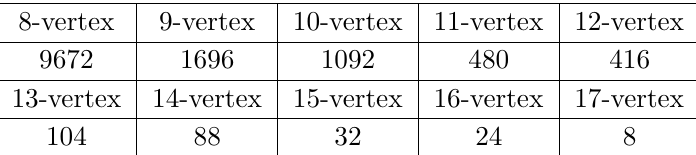
Table 2 . The numbers for various types of vertices in P (3 ; 8), classi(cid:12)ed by the number of facets adjacent to each